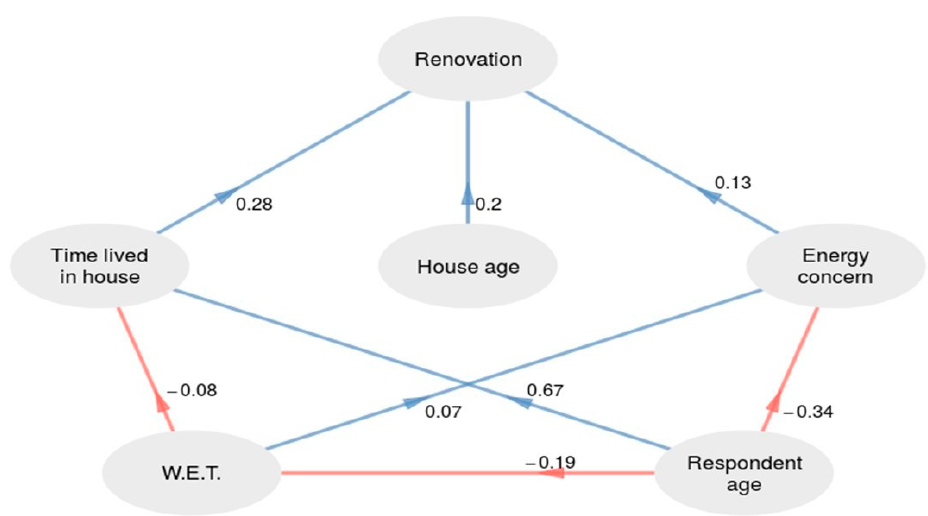
Figure 3. Path coefficients for the renovation PLSPM model.